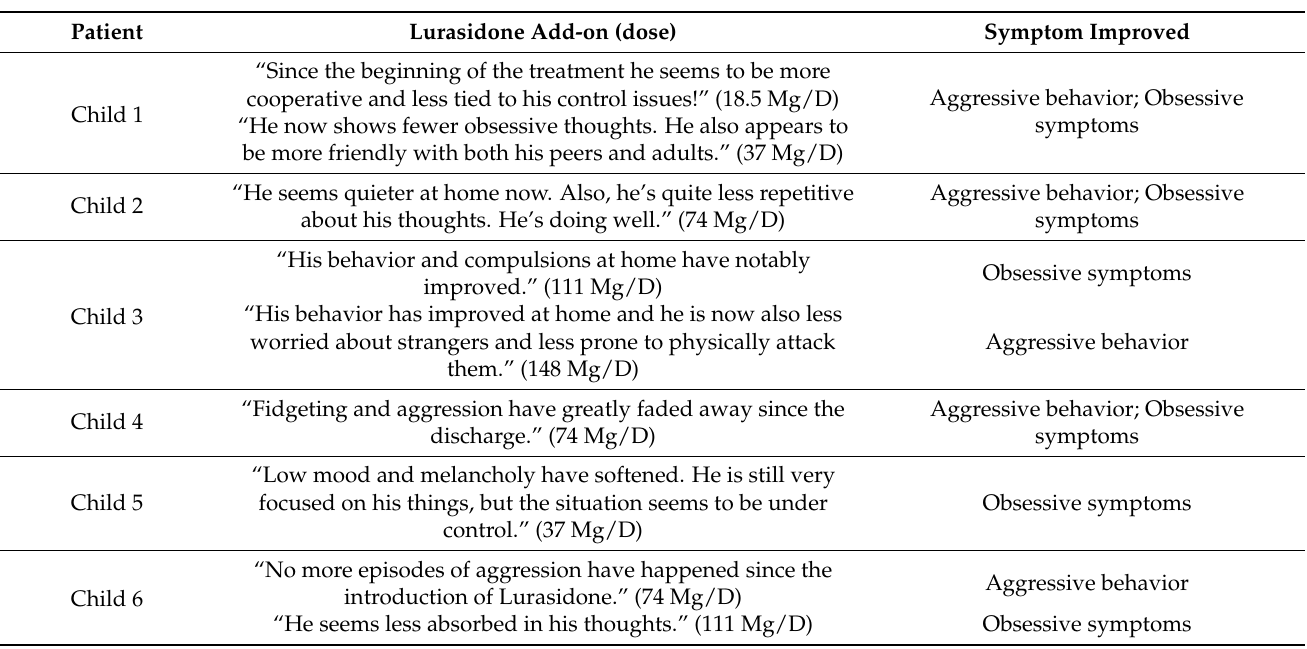
Table 5. Parents’